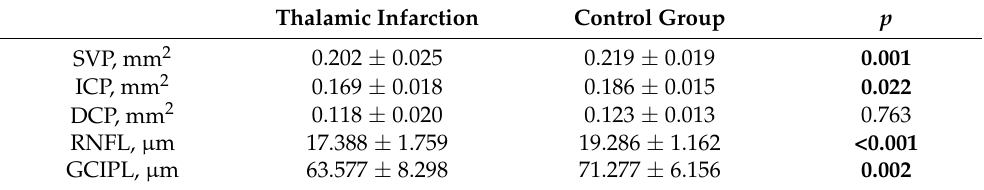
Table 2. Comparison of SS-OCT/SS-OCTA parameters between thalamic infarction and control group. Thalamic Infarction Control Group p SVP, mm 2 0.202 ± 0.025 0.219 ± 0.019 0.001 ICP, mm 2 0.169 ± 0.018 0.186 ± 0.015 0.022 DCP, mm 2 0.118 ± 0.020 0.123 ± 0.013 0.763 RNFL, µ m 17.388 ± 1.759 19.286 ± 1.162 <0.001 GCIPL, µ m 63.577 ± 8.298 71.277 ± 6.156 0.002